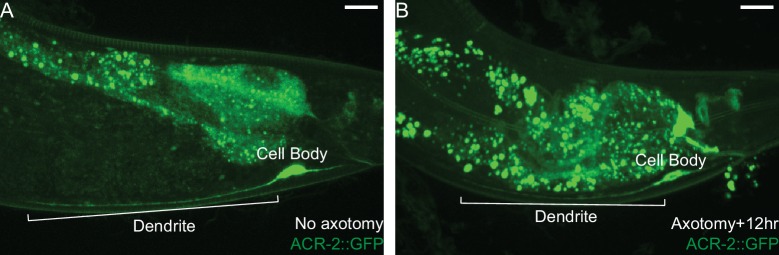
ACR-2, a subunit of the nicotinic acetylcholine receptor, maintains dendritic localization after axotomy.(A) ACR-2::GFP localizes to the dendrite and soma of DA9 in intact ric-7(n2657) animals. The scale bar = 10 μm. (B) ACR-2::GFP still localizes to the dendrite and soma of DA9 in axotomized ric-7(n2657) animals 12 hr after axotomy. The scale bar = 10 μm.